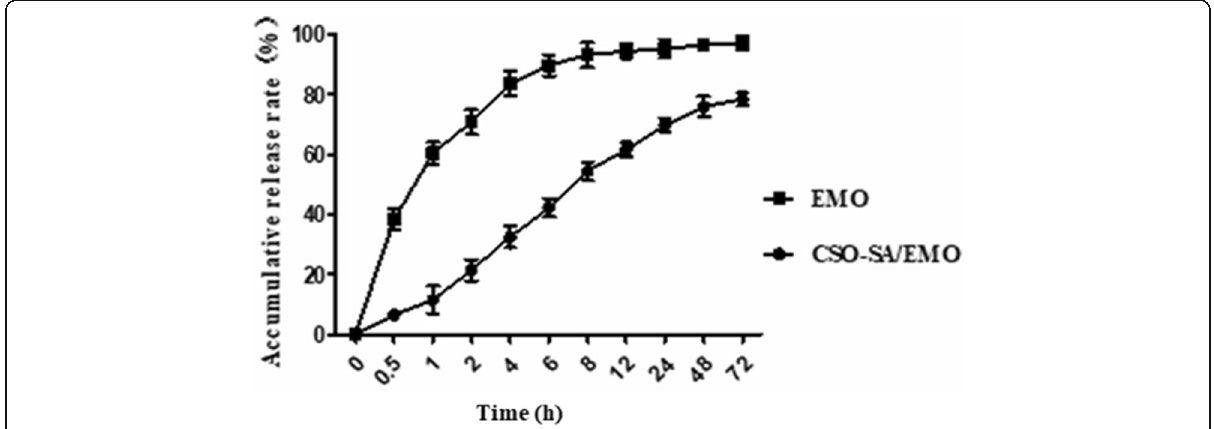
Fig. 6 EMO release profile from CSO-SA/EMO over 72 h. Error bars in the graph represent the standard deviations ( n =